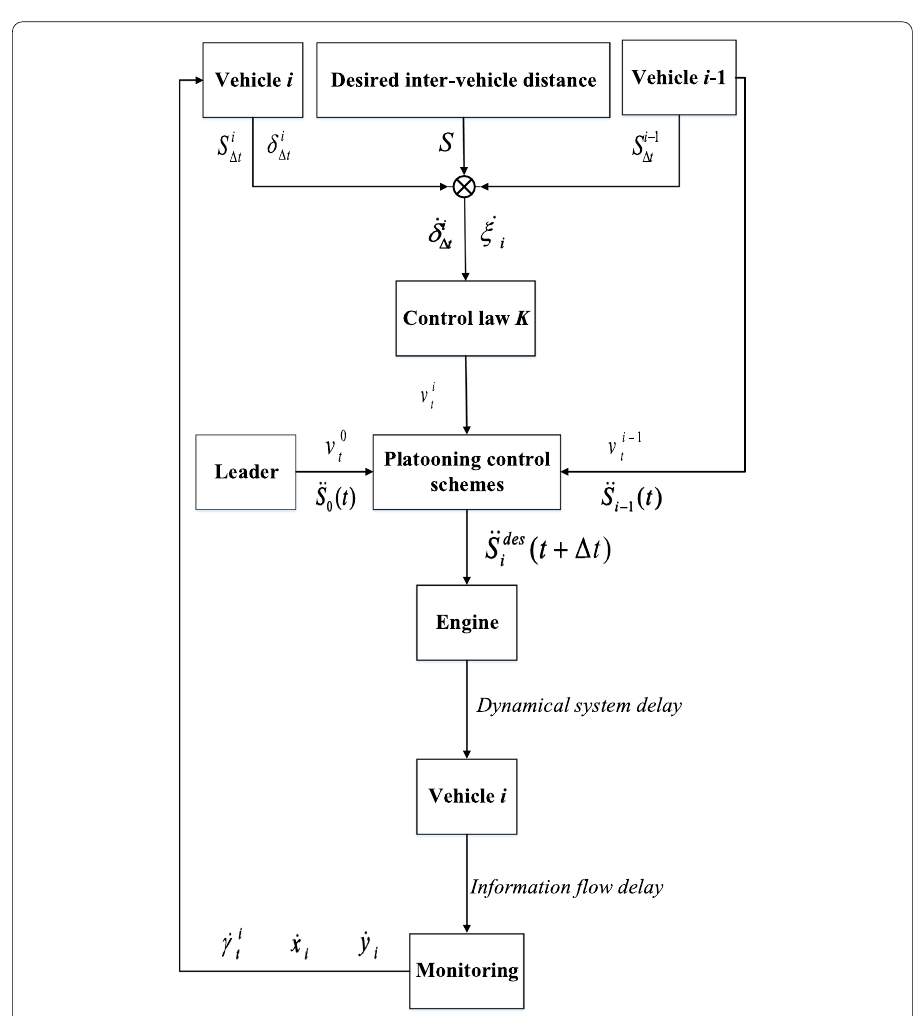
Fig. 4 Flow chart of the platooning control